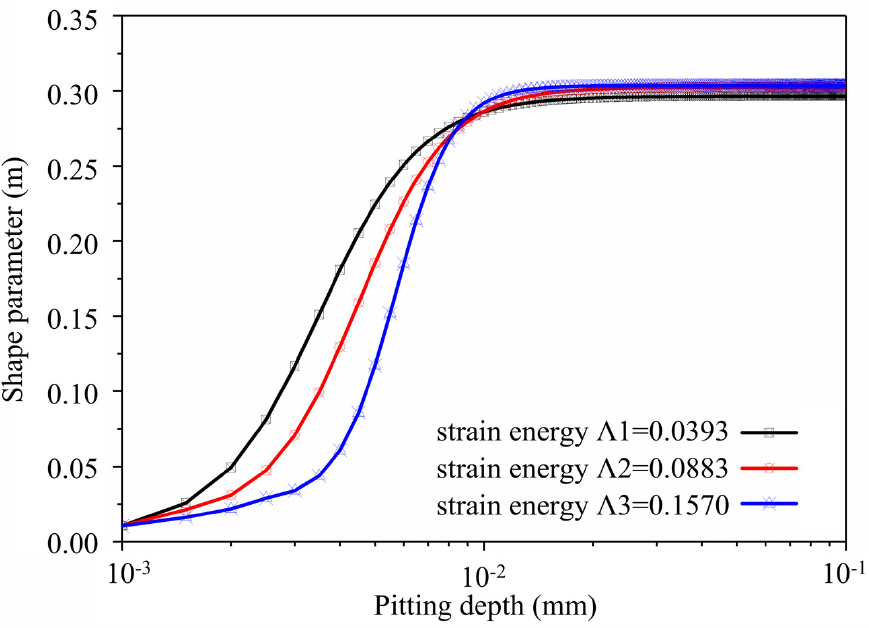
Figure 14. Curve of Shape Parameter with the Change in Pit Depth in the Pitting Developing Pro- cess.